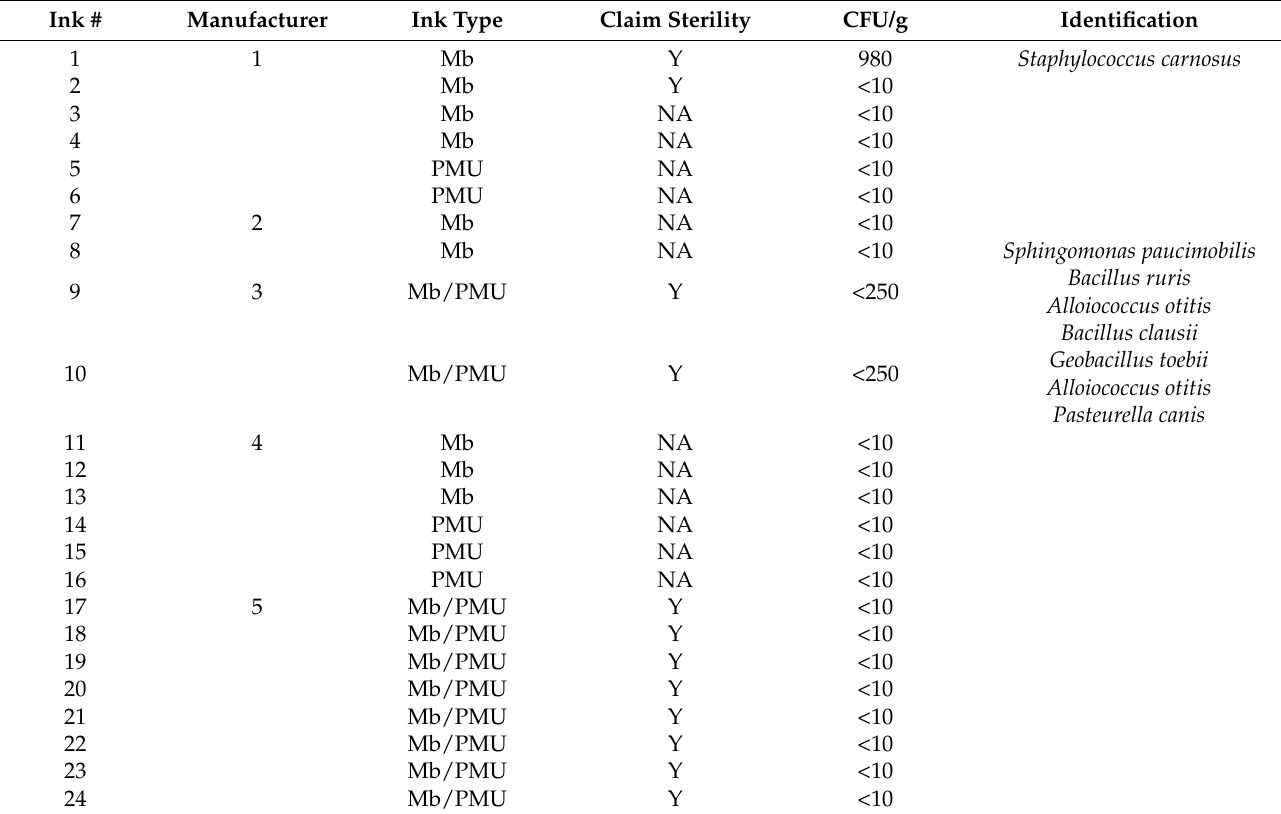
Table 1. Detection and identification of microorganisms in PMU